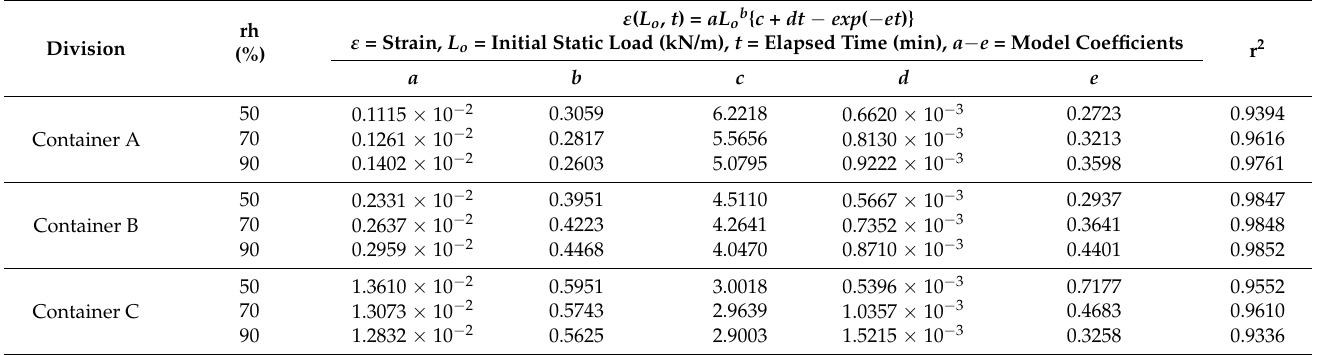
Table 6. The 12 h creep behavior modeling results for the target shipping containers.